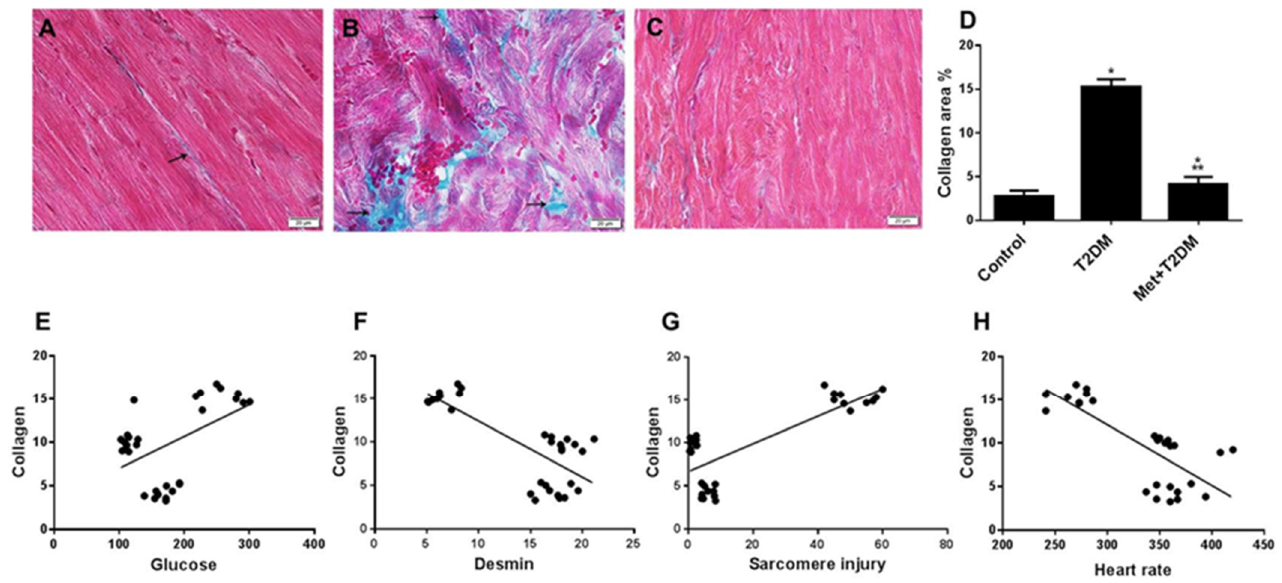
Figure 4. Metformin (Met) protects against cardiac fibrosis secondary to T2DM. Masson’s trichrome-stained images (400×) of left ventricles obtained 10 weeks post diabetic induction from the untreated control ( A ), T2DM ( B ), and Met + T2DM ( C ) groups are visualized using light microscopy (Scale = 20 μ m). Note that the arrows point to collagen deposition. Histograms in ( D ) represent a quantitative analysis of collagen area % in cardiac sections from the above groups. ( E – H ) Correlation between collagen deposition (fibrosis) score and glucose levels ( E ), desmin ( F ), sarcomere injury ( G ), and heart rate ( H ). The presented p values are all significant. * p < 0.01 versus control, ** p < 0.0001 versus T2DM. T2DM: type 2 diabetes mellitus.